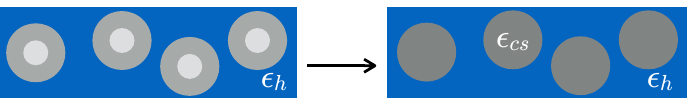
Figure 1. Scheme of the effective medium problem of composite with spherical core-shell type inclusions: the system formed by a composite with core-shell inclusions can be reduced to that of a composite with homogeneous spheres with effective dielectric function (cid:101) cs . The value of (cid:101) cs is obtained by applying an effective medium theory on the core-shell